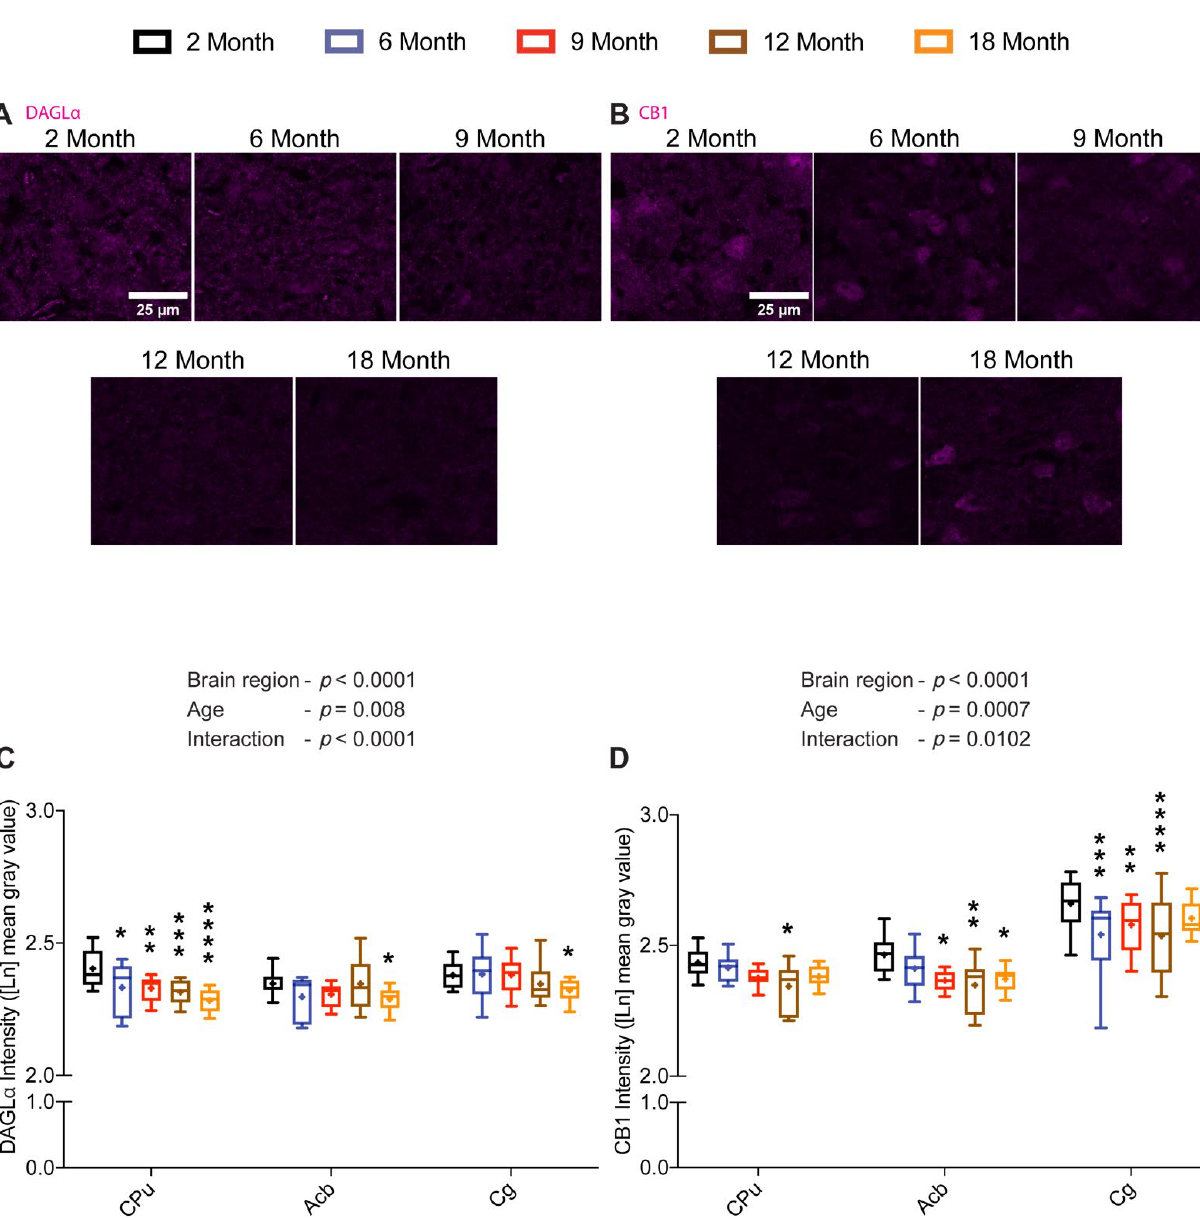
Figure 4. Age-related changes in DAGL α and CB1 protein levels in the limbic forebrain. Brain sections of 2-, 6-, 9-, 12- and 18-month-old mice were immunostained for DAGL α and CB1. Representative images depicting DAGL α and CB1 immunoreactivity in the striatum (scale bar = 25 μm) ( A , B ). Quantification of DAGLα ( C ) and CB1 ( D ) immunoreactivity in different limbic forebrain regions showed significant changes in DAGL α and CB1 protein levels in a region-specific manner with respect to age ( n = 12–16 images were analyzed per region from 3–4 mice per age group). Whiskers represent minimum and maximum values; + symbol within the box indicates mean; * p < 0.05; ** p < 0.01; *** p < 0.001; **** p < 0.0001; linear mixed model analysis followed by Dunnett´s multiple comparison test. p -values refer to pairwise tests against the 2-month-old group.